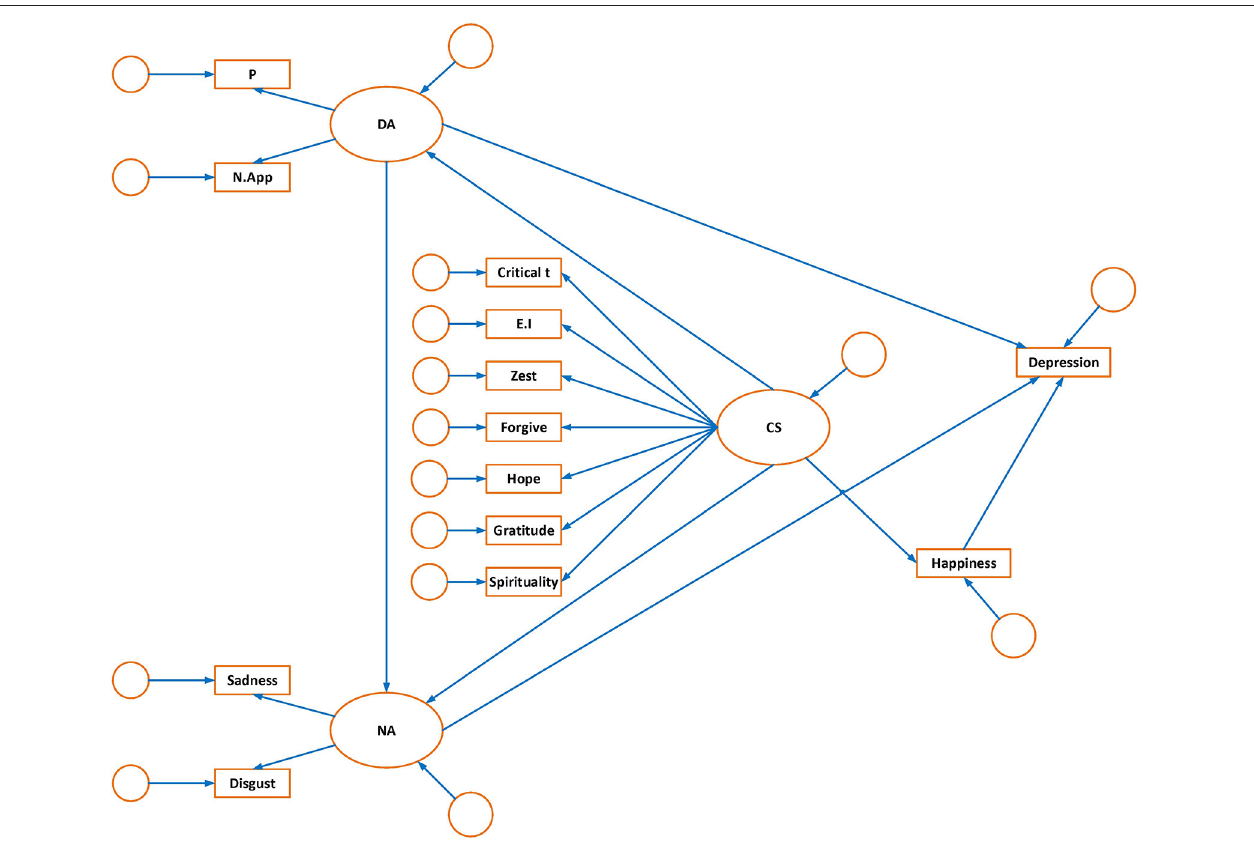
FIGURE 1 | Hypothesized model of depression:measuremen t and structural components. OA, dysfunctional attitude; P, perfectionism; N.App, need for approval; NA, negative affect; Critical T, critical thinking; CS, character strength; E. I, emotional